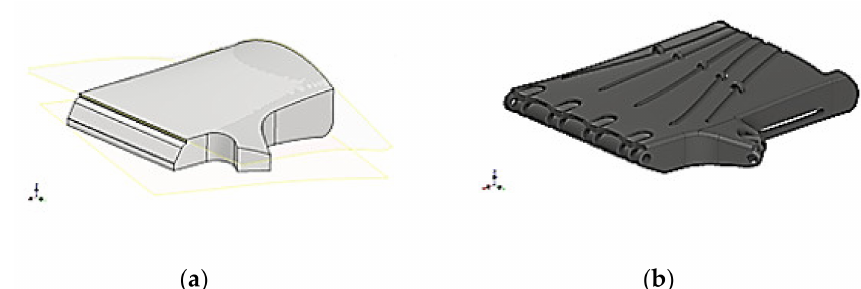
Figure 7. CAD development of the palmar region: ( a ) simple geometry of palmar region, ( b ) developed palmar region.